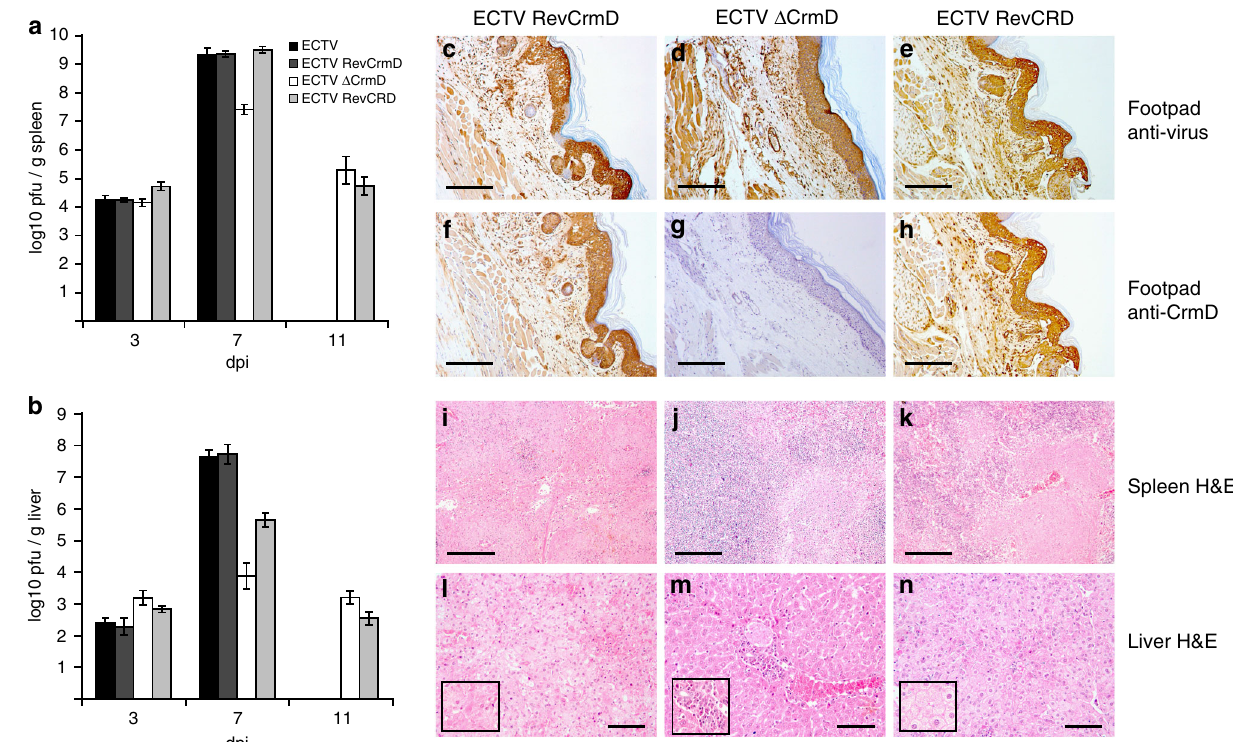
Fig. 5 Impaired virus spread in the absence of ECTV CrmD. Graphs show viral titres at 3, 7 and 11 dpi in spleen ( a ) and liver ( b ) of BALB/c mice infected with 1000PFU per animal of the indicated viruses. Data are mean log + / − SEM of groups of fi ve animals for each condition. Note that mice infected with ECTV or ECTVRevCrmD did not survive up to 11 dpi. Left hind foot anti-poxvirus staining ( c – e ) or anti-CrmD staining ( f – h ) of zinc- fi xed footpad sections of representative BALB/c mice infected with 1000 PFU of ECTVRevCrmD ( c, f ), ECTV Δ CrmD ( d, g ) or ECTVRevCRD ( e, h ) at 7 dpi. H&E staining of spleen ( i – k ) or liver ( l – n ) sections of representative mice infected with 1000 PFU of ECTVRevCrmD ( i, l ), ECTV Δ CrmD ( j, m ) or ECTVRevCRD ( k, n ) at 7 dpi. Insets show enlargement of selected areas to illustrate necrosis ( l , n ) and in fl ammatory in fi ltrate ( m ). Data are from one experiment representative of two independent experiments. Scale bar, 100 µ m ( c – k ) and 40 µ m ( l – n